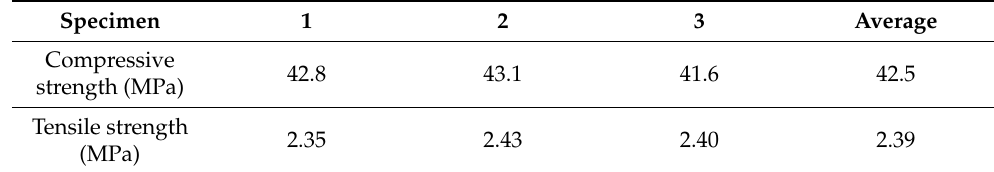
Table 1. Axial compressive strength of